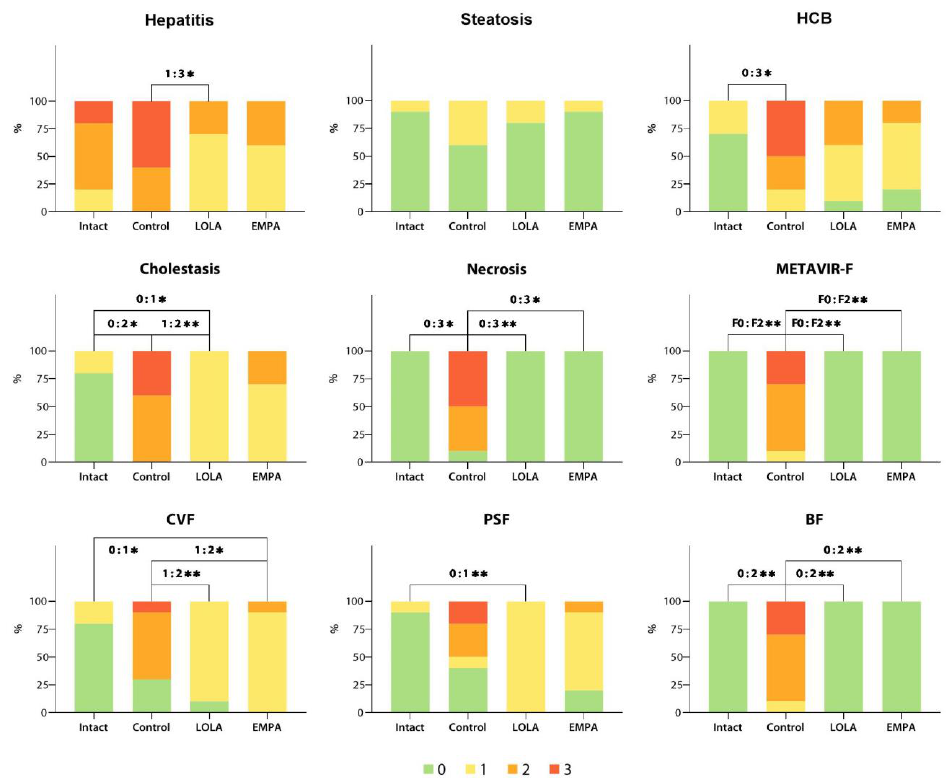
Figure 7. Observed histological score frequency distributions among experimental groups. HCB, hepatocellular ballooning; CVF, central vein fibrosis; PSF, perisinusoidal fibrosis; BF, bridging fibrosis; * p < 0.05; ** p < 0.01.